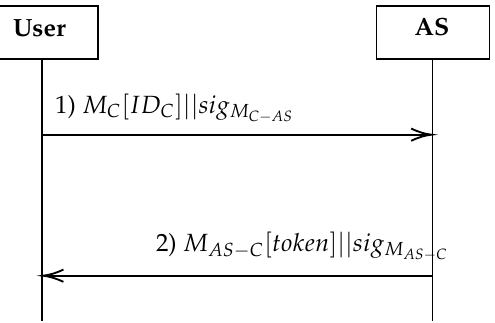
Figure 2. Sequence diagram for communication between the user and